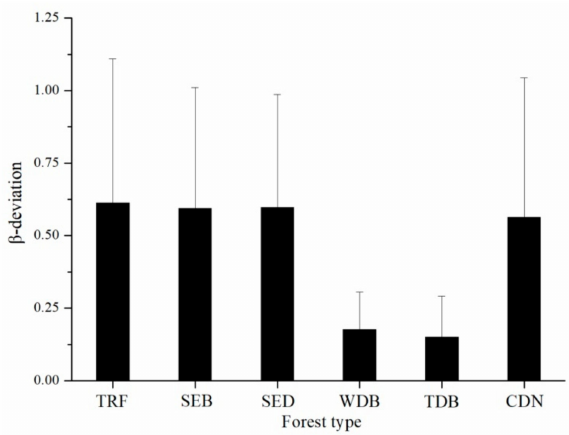
Figure 4. Variation in soil fungal β -deviation in six forest types along a latitudinal gradient.